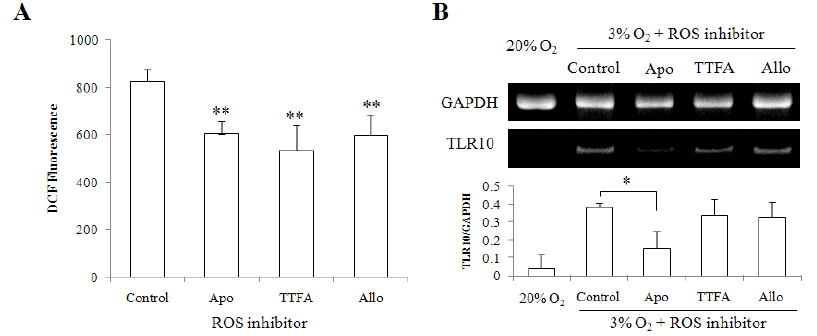
Figure 3. NADPH oxidase inhibitor suppressed intracellular ROS production and TLR10 mRNA expression in THP-1 cells cultured in hypoxia. ( A ) Intracellular ROS production was examined in THP-1 cells grown in 3% O for 2 days in the presence of three different 2 ROS synthesis inhibitors; Apocynin (Apo, 100 μM), NADPH oxidase inhibitor; TTFA (100 μM), mitochondria electron transport chain complex II inhibitor; Allopurinol (Allo, 100 μM), xanthine oxidase inhibitor. After cultivation, the cells were incubated with 10 μM DCFH-DA for 15 min at 37 °C and assessed by FACS analysis; ( B ) A representative RT-PCR data showing TLR10 expression in THP-1 cells treated with ROS synthesis inhibitor. The cells grown in 3% O for 3 days in the presence or absence of three 2 different ROS synthesis inhibitors were harvested and examined by RT-PCR analysis. The relative expression of TLR10 was normalized by GAPDH using densitometric analysis. * P < 0.05, ** P <